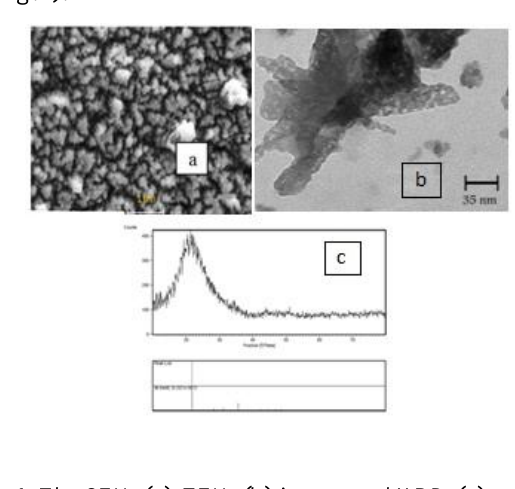
Fig.1. The SEM (a), TEM (b) images and XRD (c) pattern of